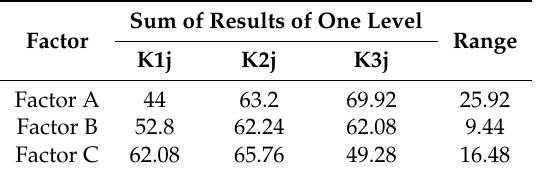
Table 5. The range analysis of the orthogonal experiment of adhesion as the target result. Sum of Results of One Level Factor